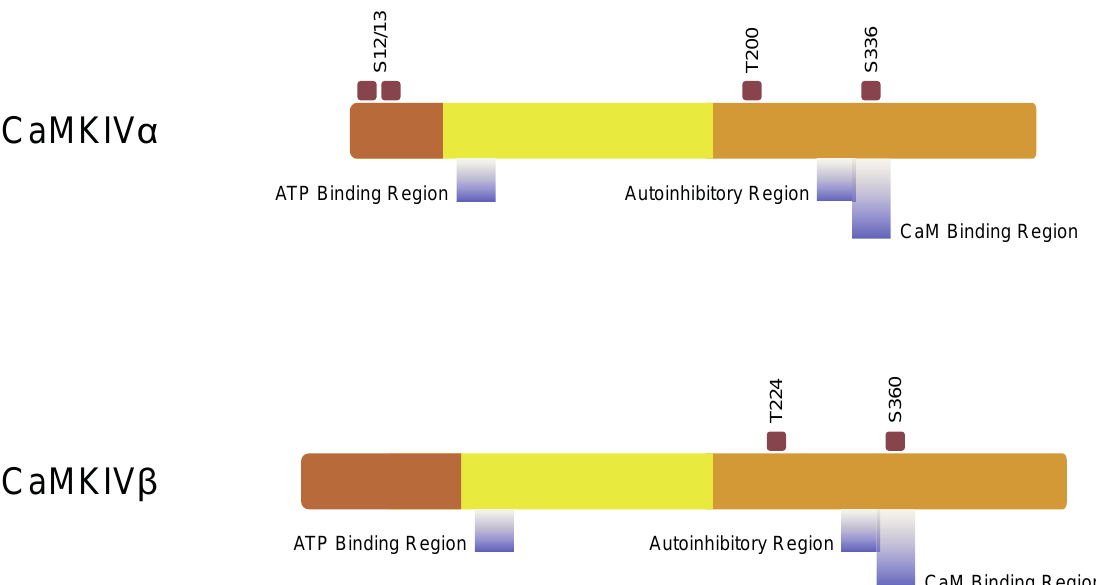
Figure 3. A domain structure of calcium/calmodulin-dependent kinase (CaMK) IV (adapted from ref. [1]). We distinguish two CaMKIV isoforms: α and β . CaMKIV structure consists of the N-terminal domain (dark brown), catalytic domain (yellow), regulatory domain (brown). Brown squares indicate phosphorylation